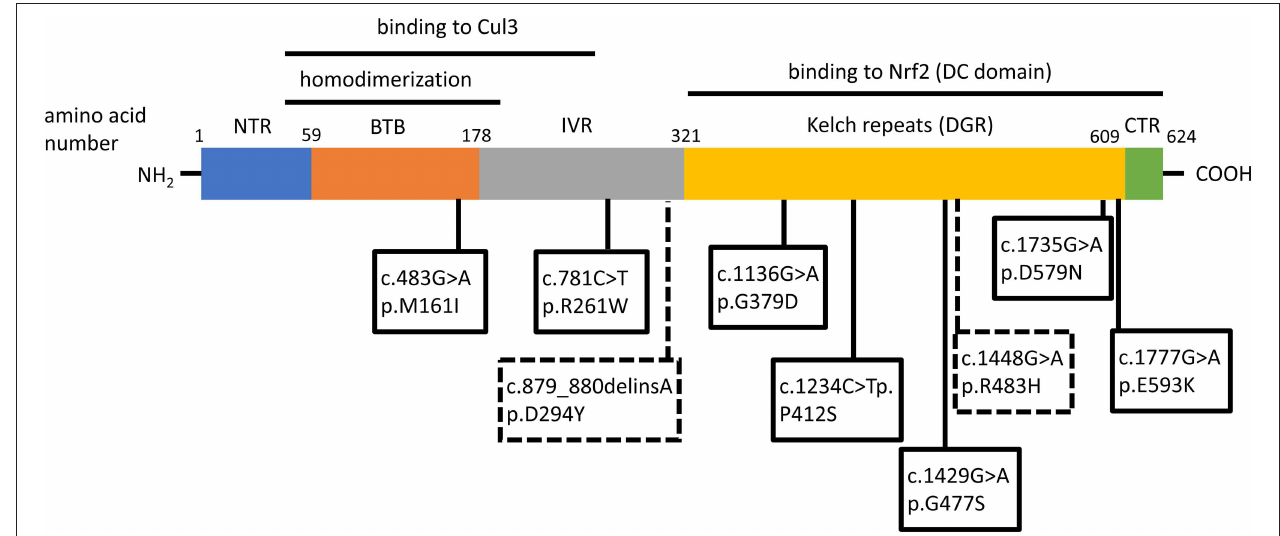
FIGURE 3 | Schematic structure of the Keap1 protein and mutations involved in thyroid gland disorders. Functional regions are indicated with corresponding amino acid number. Dotted lines and rectangles represent germline mutations involved in hereditary multinodular goiter. Solid lines and rectangles represent somatic mutations involved in thyroid cancers. Cul3: Cullin 3; NTR: netrin-like domain; BTB: Broad-Complex, Tramtrack and Bric-a-Brac; IVR: Intervening Region; DRG: Double-Glycine Repeat; DC: DGR and CTR, double-glycine repeat and C-terminal region; CTR: C-terminal Region; NTR: N-terminal Region; NH 2 : amino-terminal end; COOH: carboxy-terminal